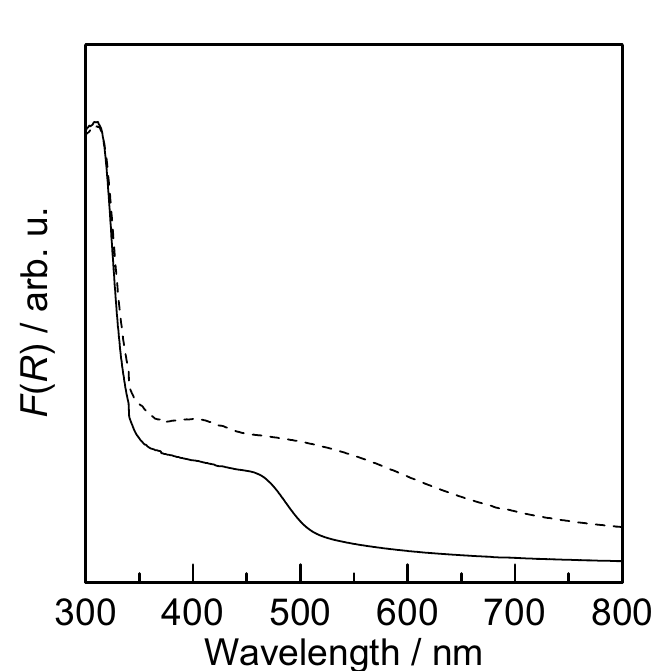
Figure 8. Wavelength dependence of F ( R ) for coatings obtained by calcination at 300 °C (dashed line) and 500 °C (solid